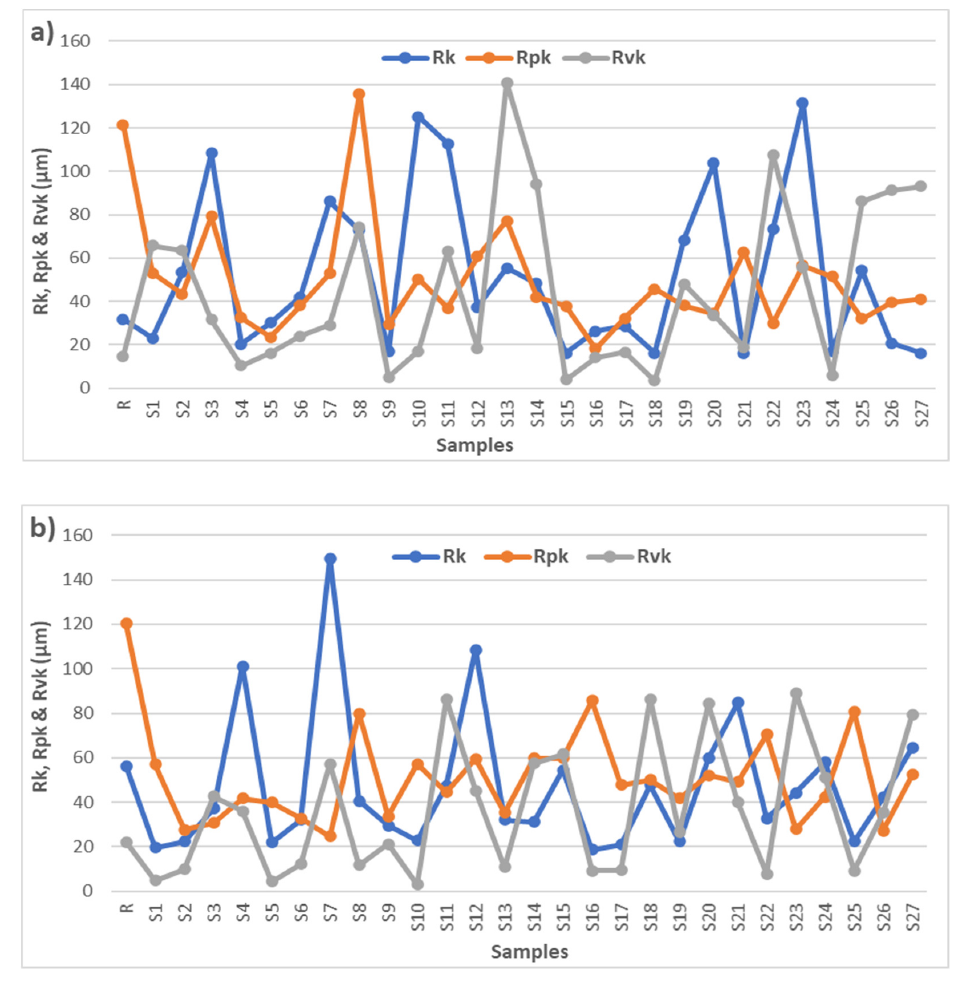
Figure 6. Rk, Rpk and Rvk assessment: ( a ) ABS material; ( b ) ASA material.